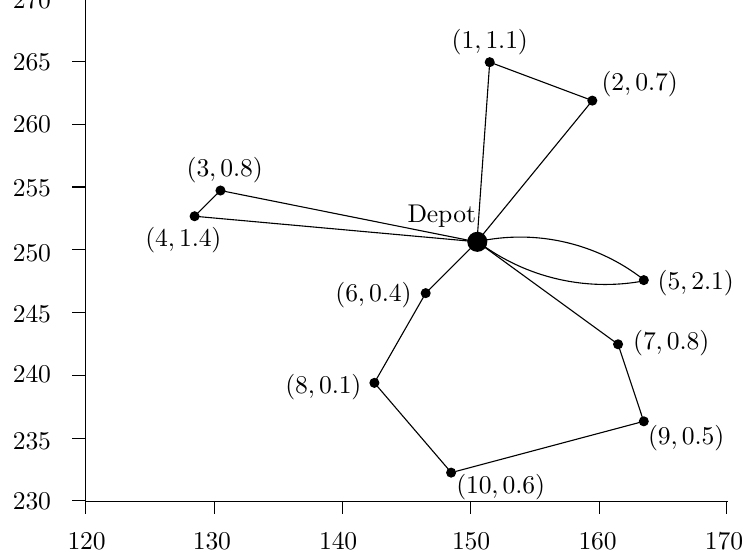
Figure 1: The four routes determined by the savings methods for the illustrative example. be deselected. Holmes and Parker (1976) developed an algorithm designed to